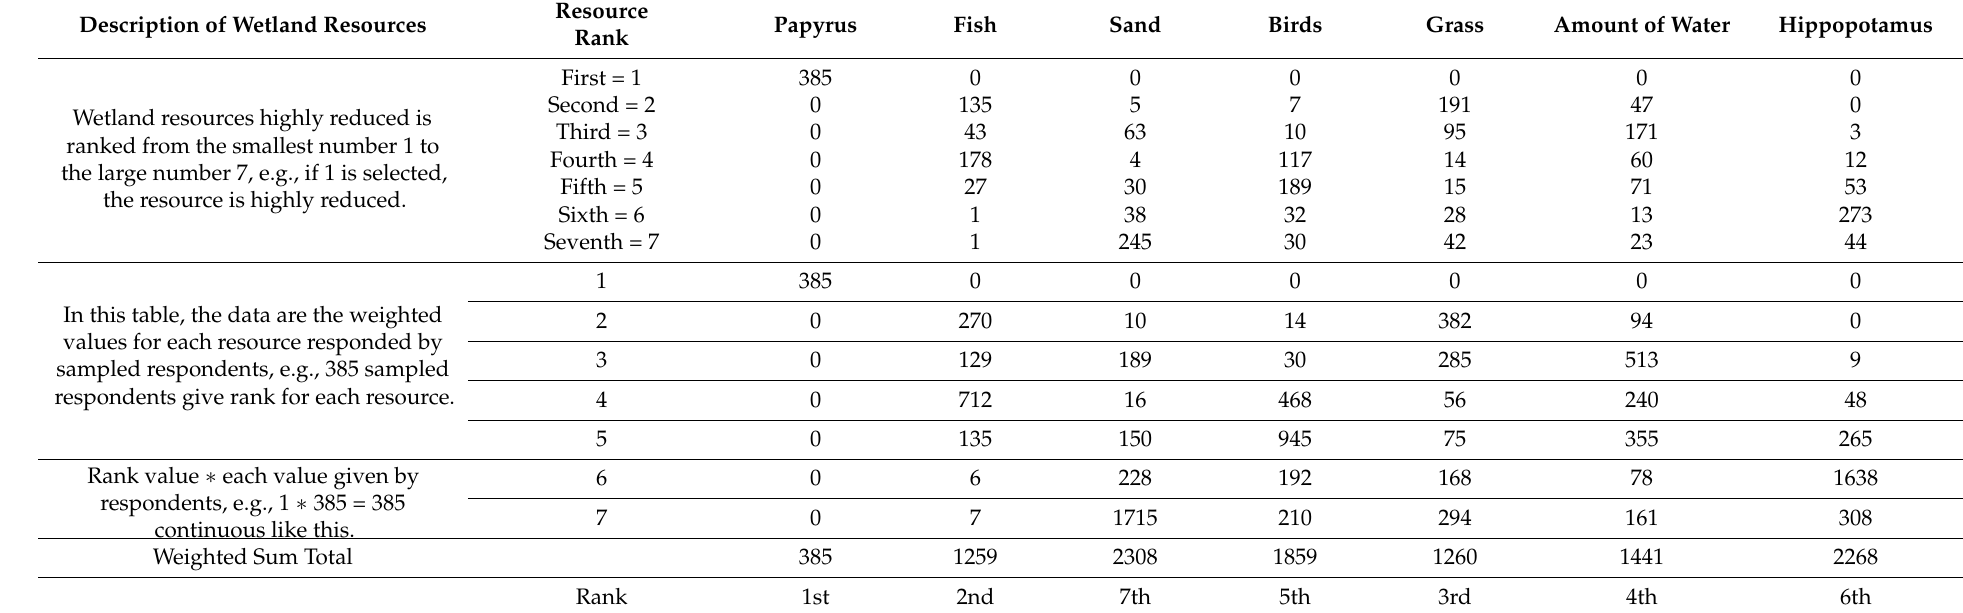
Table 8. Rank of wetland and Lake Tana